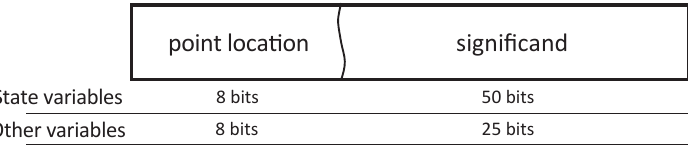
Figure 4. LOCOFloat floating-point format.